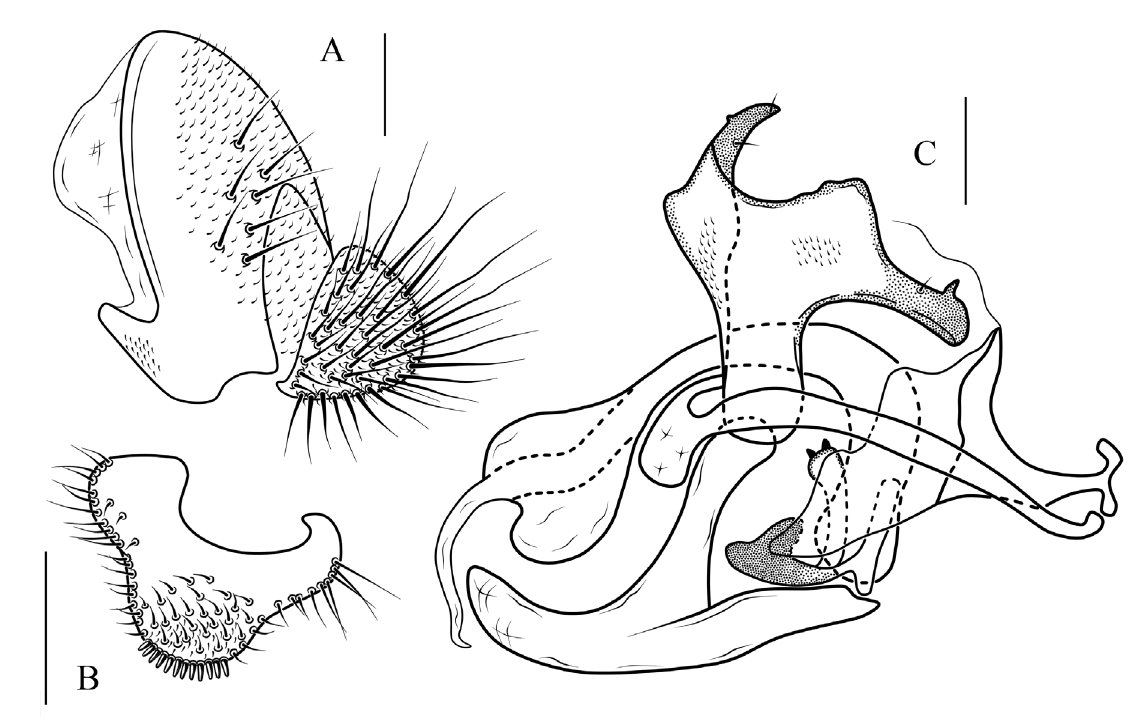
Fig. 6. Phortica ( Phortica ) yena sp. nov., ♂. A . Epandrium and cercus; B . Surstylus; C . Hypandrium, paramere, aedeagus and aedeagal apodeme. Scale bars = 0.1